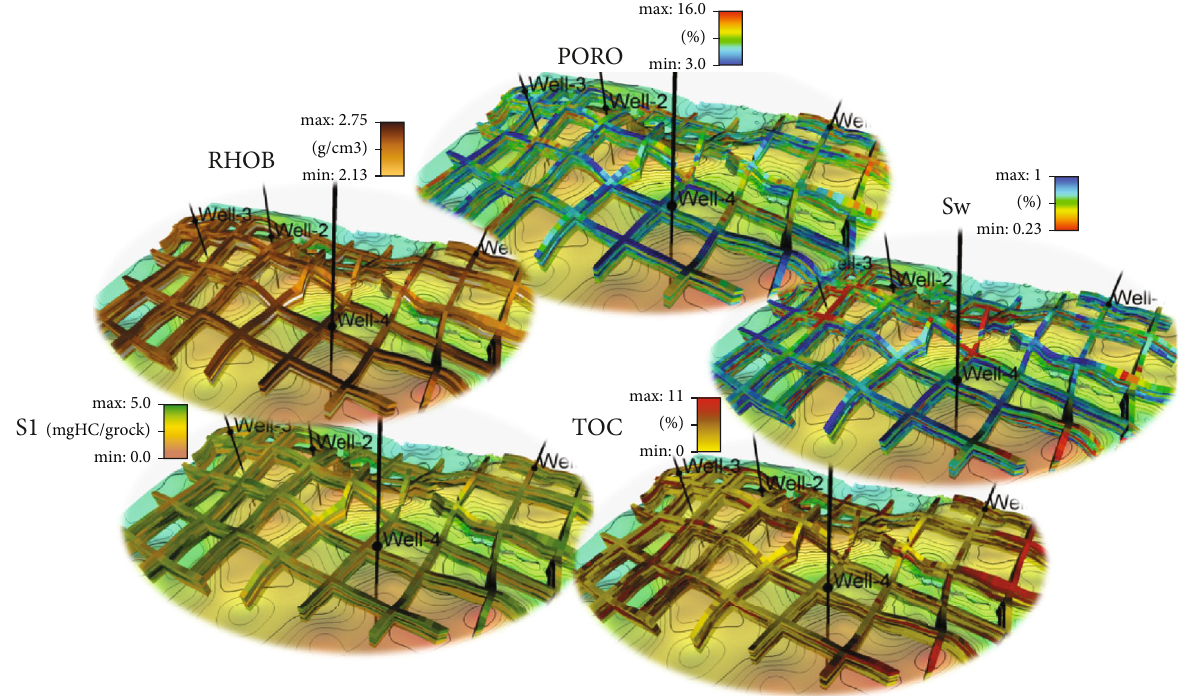
Figure 3: Reservoir modeling results — 3D distributions of properties used for oil resource calculation. For the application of geochemical method, the only properties needed are rock density (RHOB) and S 1 parameter; however, modeling task included also other properties: TOC — which was used to support S 1 parameter modeling, porosity, and water saturation (Sw), which were used for geochemical method validation with standard volumetric